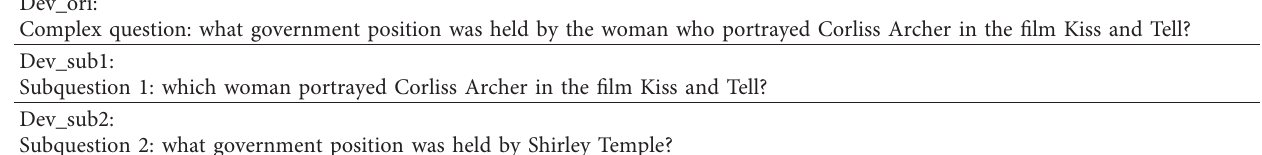
Figure 11: Evaluation metrics (with two Table 3: An example in the subquestion dataset.